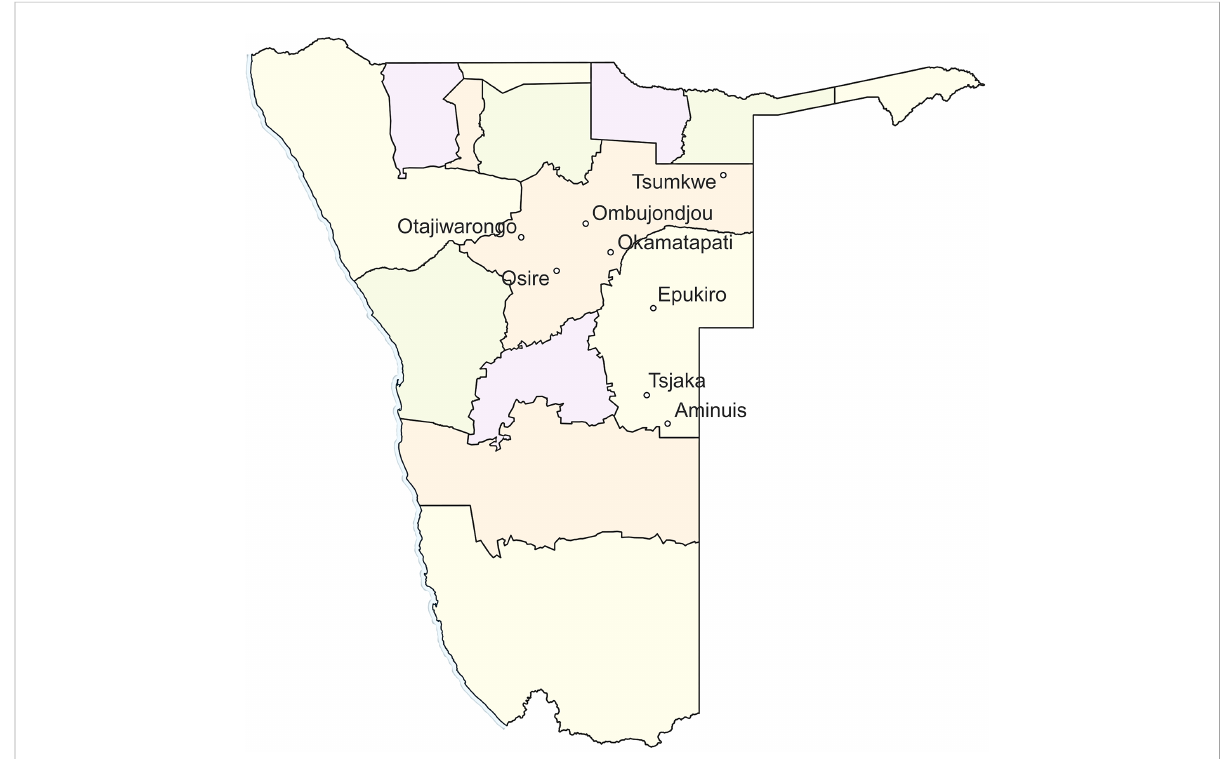
FIGURE 1 A map of Namibia showing the eight different locations where the wild marama samples were